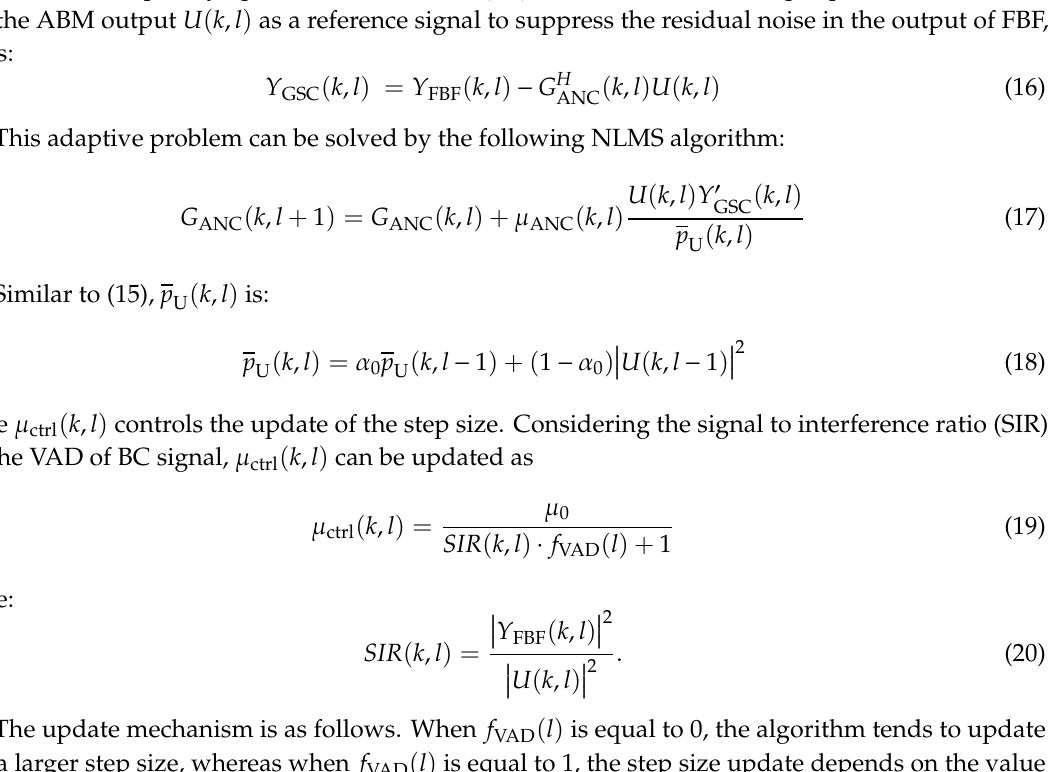
Figure 4. The framework of the proposed BC signal-assisted adaptive beamforming algorithm for speech enhancement.